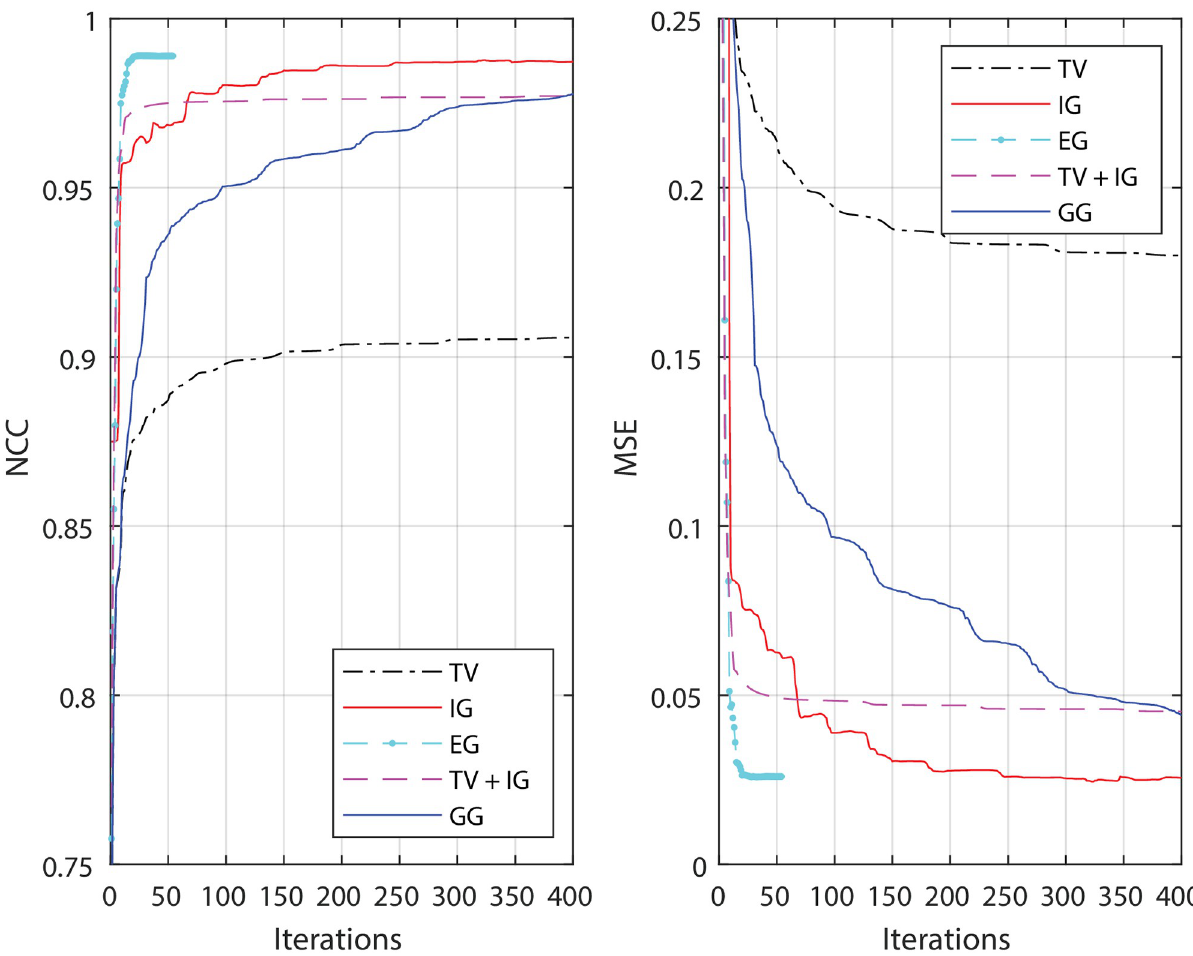
Fig 2. Error analysis of deconvolution methods. The restored image is compared to the ground truth after each iteration. Shown on the left is the plot of the normalized cross-correlation. The right graph is the plot of the mean square error which is normalized to the value of comparing the ground truth to the initial image. A larger (smaller) value in the normalized cross-correlation (mean square error) means a higher similarity. The parameters we select are the same as shown in the table in Fig 1. With these parameters, the algorithms generate the best restorations in visualization.